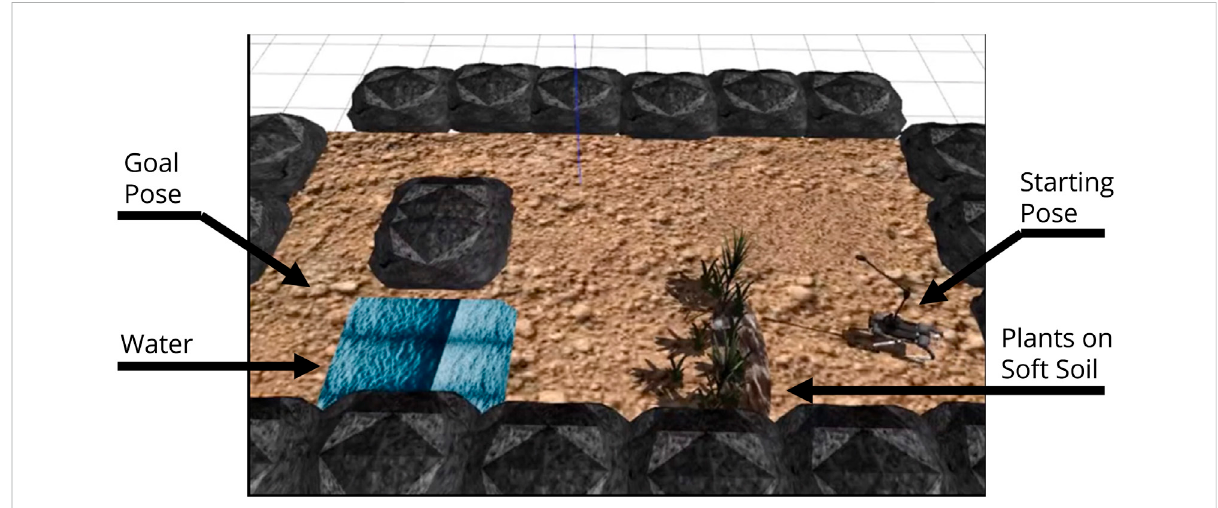
FIGURE 5 Gazebo simulation environment: traversability – navigation pipeline with terrain probing scenario includes deep water and plants on untraversable soft soil.